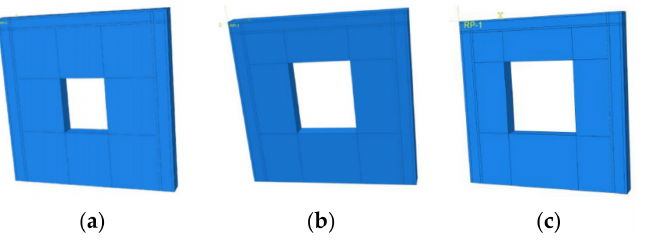
Figure 22. Wall models with different window holes’ dimensions: ( a ) wall ZWZ-4; ( b ) wall ZWZ-5; ( c ) wall ZWZ-6. Table 8. Bearing capacity values of the walls with different window holes’ dimensions.